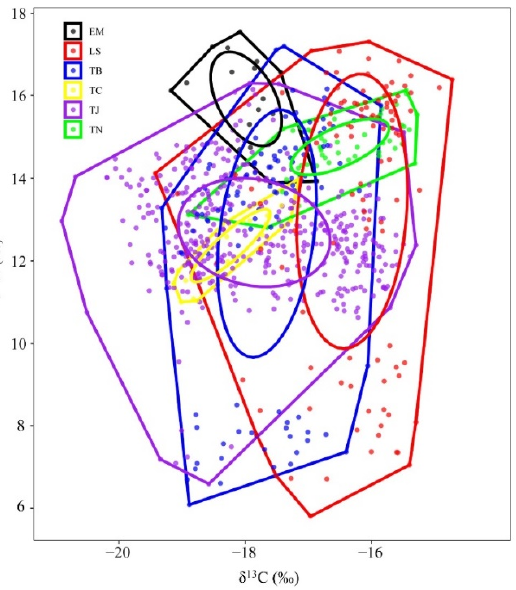
Figure 6. Two-dimension map of trophic niches of six species of Trichiuridae in the Chinese seas. TJ, Trichiurus japonicus ; TN, T. nanhaiensis ; TB, T. brevis ; LS, Lepturacanthus savala ; EM, Eupleurogrammus muticus ; TC, Tentoriceps cristatus .